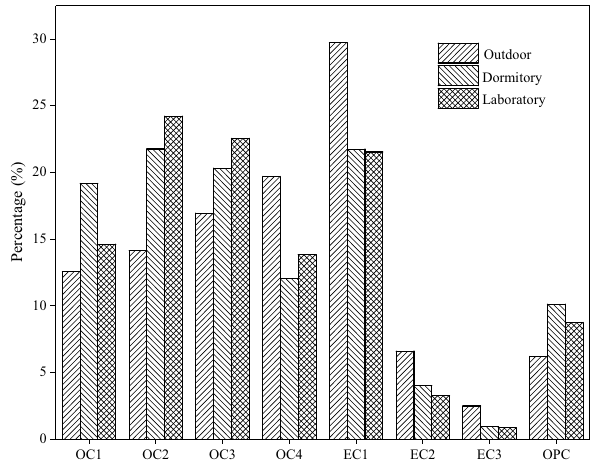
Figure 7. Ratio of eight carbon components to total carbon indoor and outdoor.